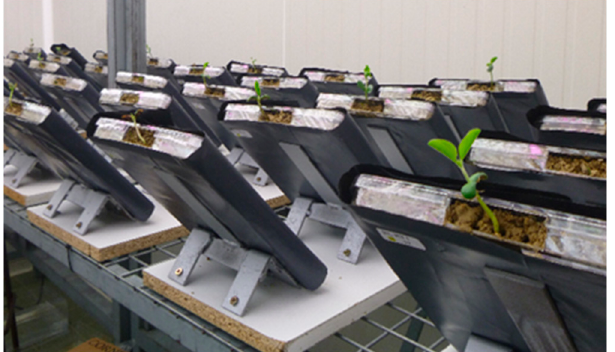
Figure 1. View of the minirhizotrons experimental design under controlled conditions (growth chamber).